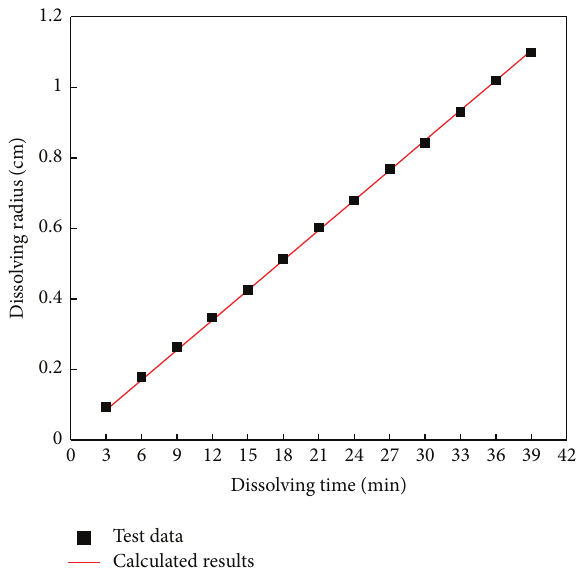
Figure 8: Comparison of the dissolved radius between test data and calculated results under 20 L/h.